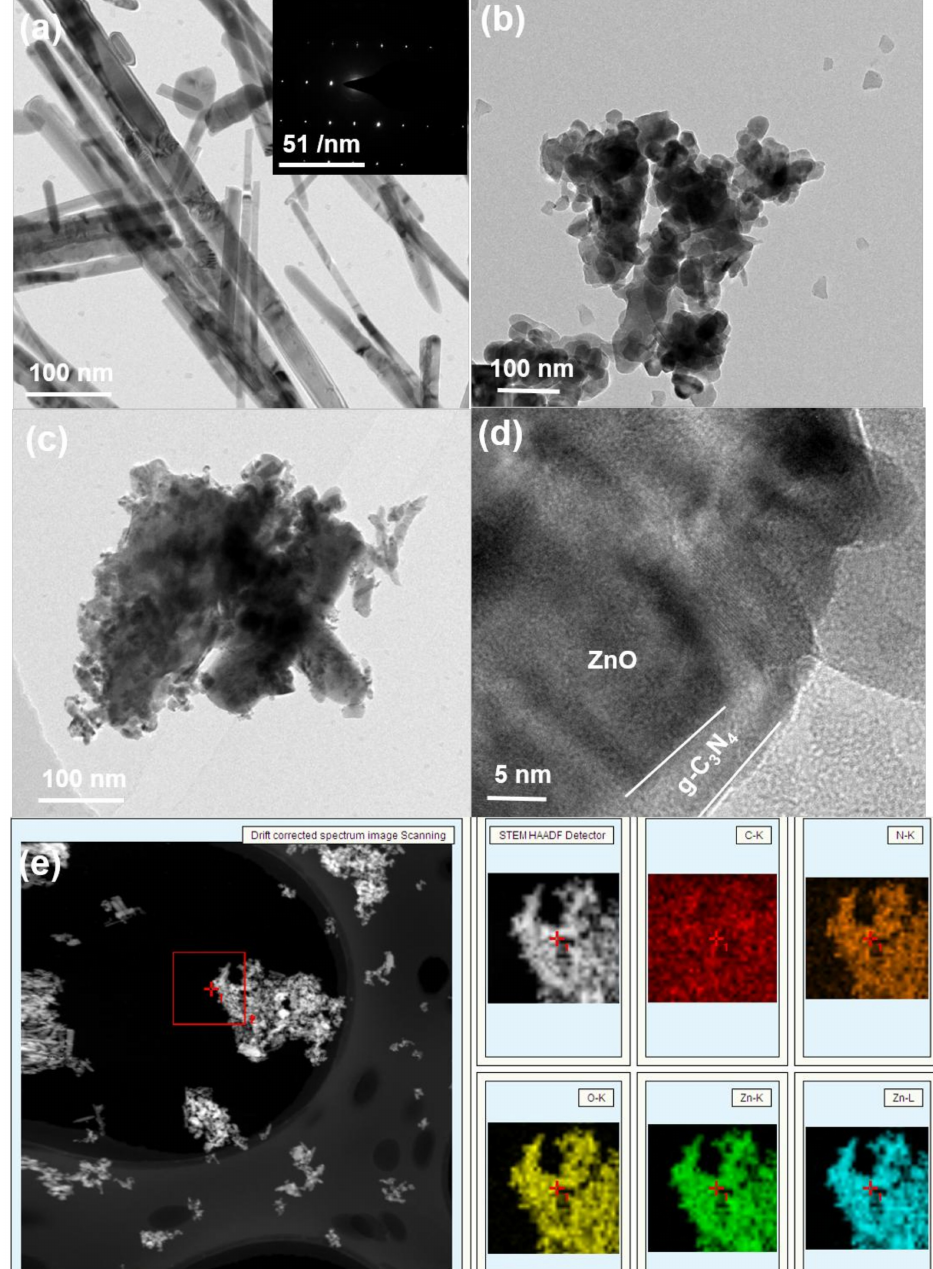
Figure 3. TEM imges of ( a ) ZnO nanorods with inserted selected area electron diffraction (SAED) pattern (inset of (a)), ( b ) 0.1:1 CN, ( c ) 0.1:1, ( d ) HRTEM of 0.1:1, low magnification of 0.1:1 CN and ( e ) the corresponding element